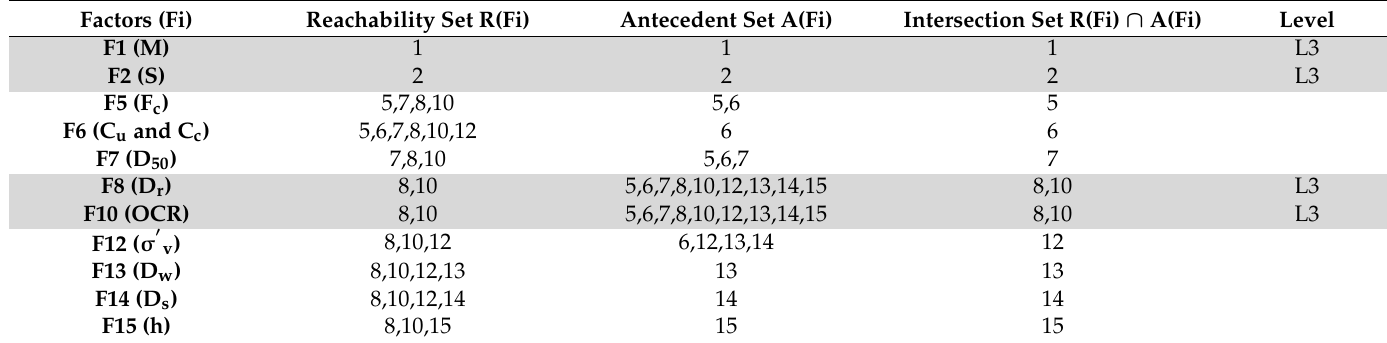
Table A5. Level partition—Iteration